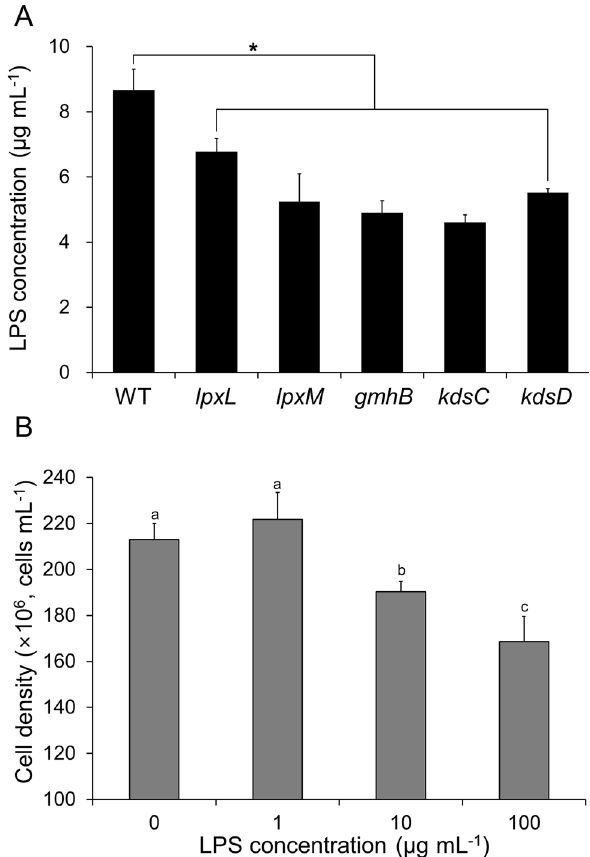
Figure 3. ( A ) Concentration of lipopolysaccharide (LPS) of wild-type (WT), lpxL, lpxM, gmhB, kdsC , and kdsD mutants cultured in bacterial medium. Error bars represent the mean ± standard deviation (SD) of triplicate experiments. * P ≤ 0.01. ( B ) Effect of LPS supplementation (0–100 µg mL −1 ) on the growth of axenic Chlorella vulgaris OW-01. Error bars represent the mean ± standard deviation (SD) from triplicate experiments. Different letters represent significant difference ( P <